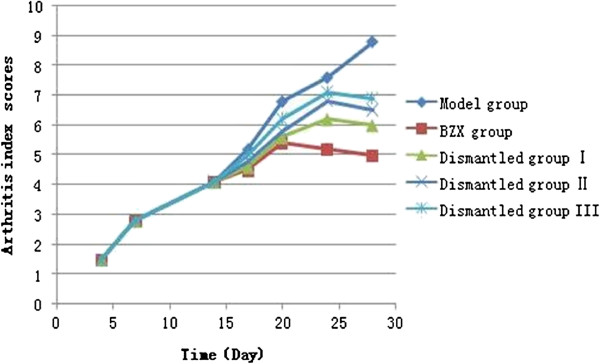
Model group, the BZX Group, dismantled group I, II, III arthritis index scores.